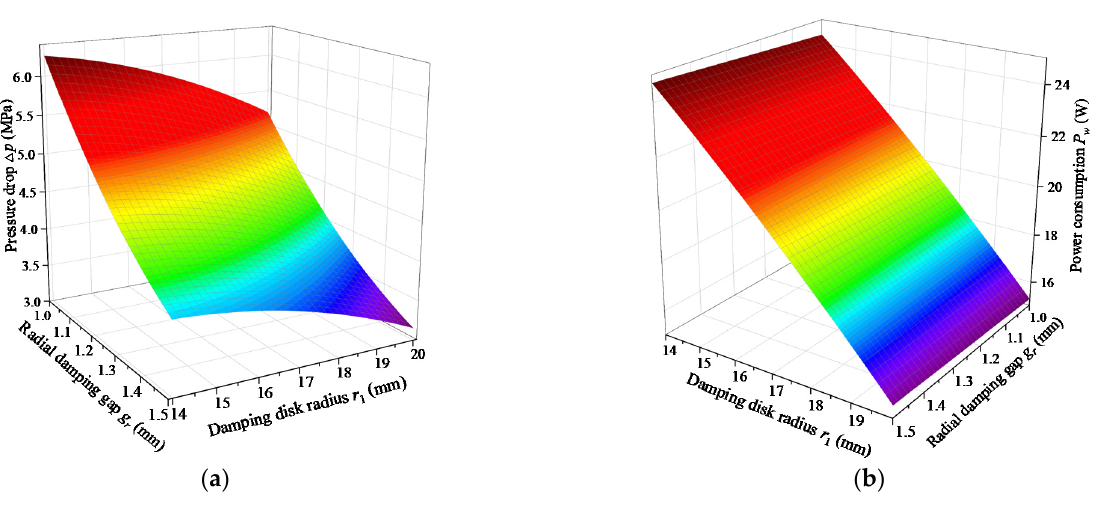
Figure 10. Fitting surface of model for g a = 1.25 mm, w 5 = 7.5 mm: ( a ) pressure drop Δ p , ( b ) power consumption P w .